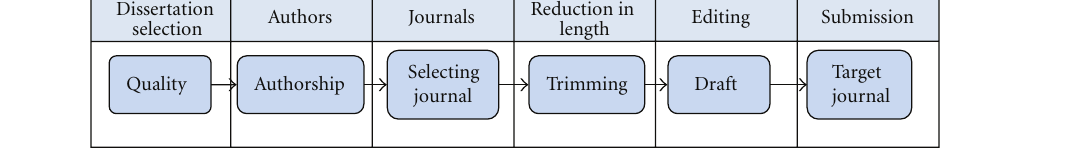
Figure 2: Publication process model.